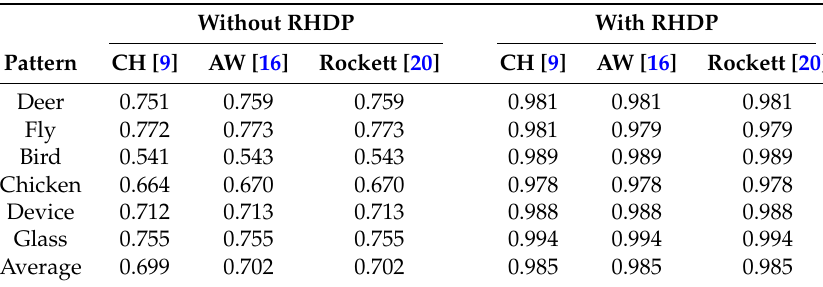
Table 6. MR measurements for the reconstruction results given in Figures 17 and 18 by applying the presented pattern reconstruction approach with three fully-parallel thinning algorithms. The average MR with the RHDP process is increased 28.4% compared to that without the RHDP